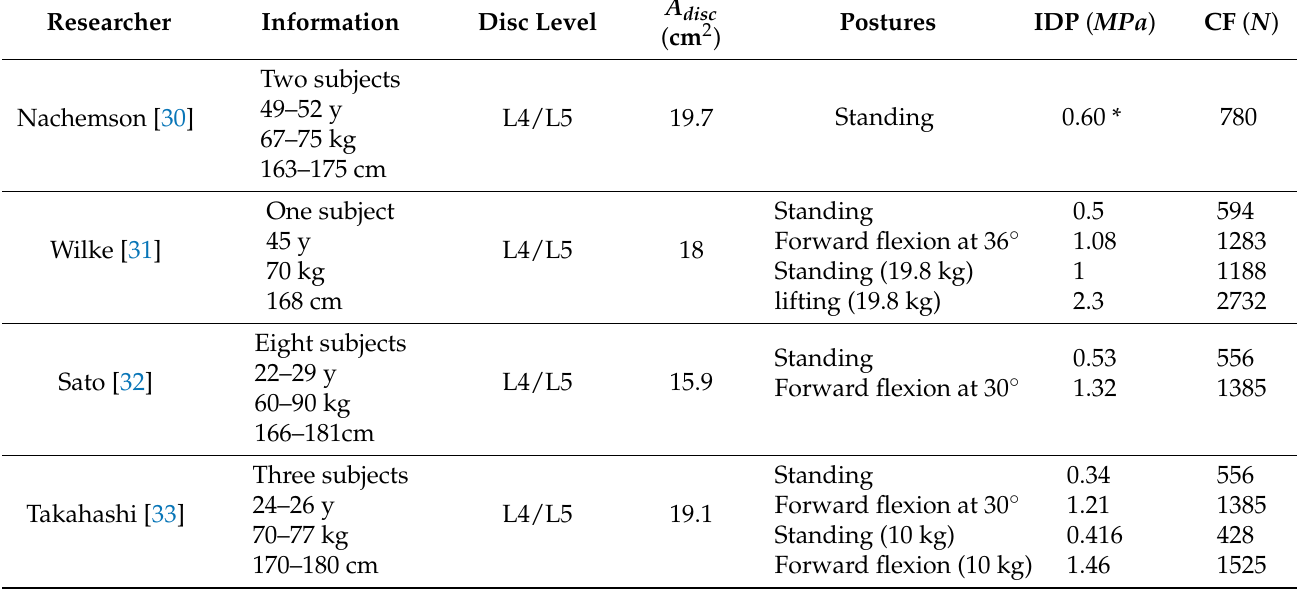
Table 2. Information of invasive intradiscal pressure (IDP)